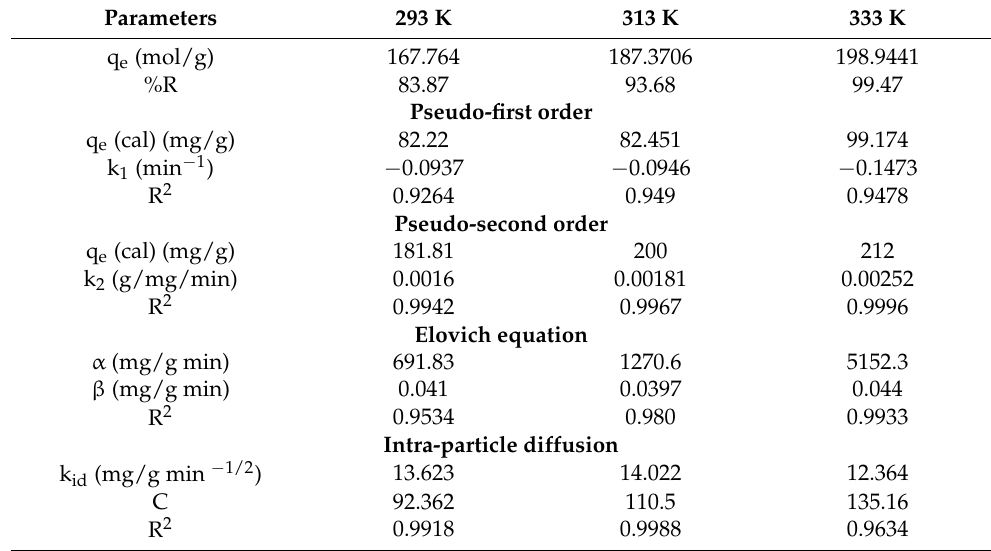
Table 2. Parameters table for different kinetic models for adsorption of AO-8 on Pd-Ni/AC-CeO 2